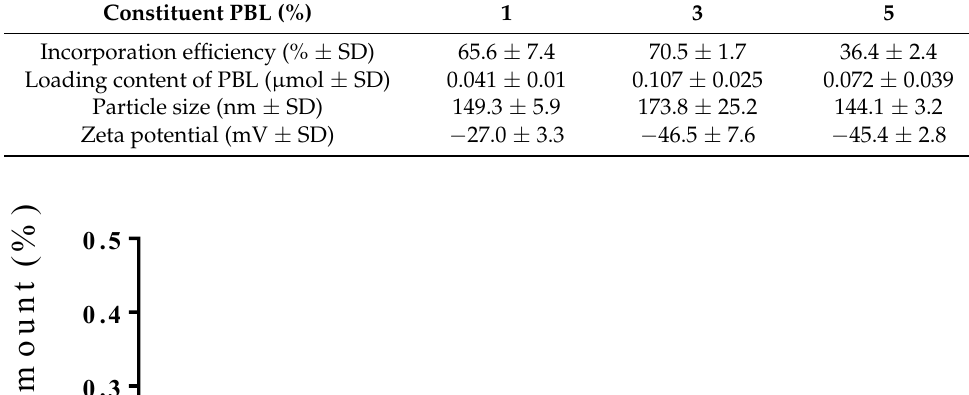
Figure 5. Stability of PBL liposome in a blood model. The stability of the drug formulation was evaluated by measuring the detachment of PBL from the PBL liposomes (PBL content of 5%) for 48h in fetal bovine serum at 37 °C. Values indicate the total amount of PBL detachment at the indicated time point ( ● ).